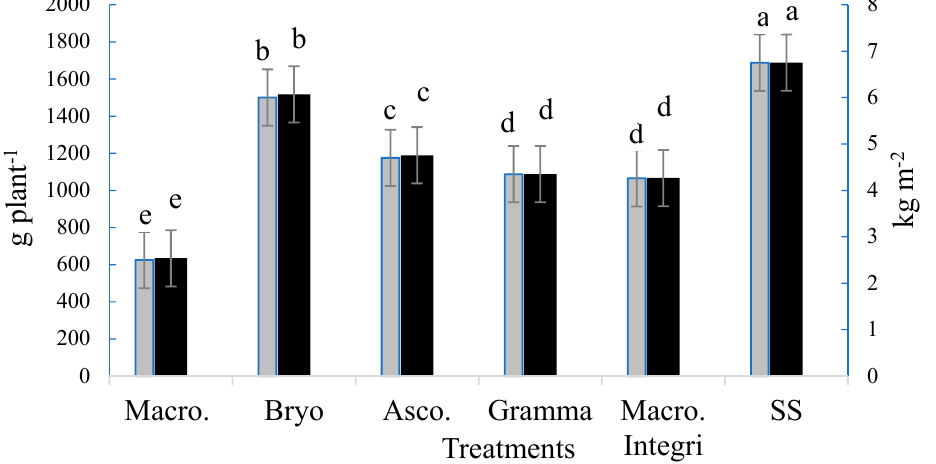
Figure 1. Effect of foliar application of seaweed extracts on the cucumber yield based on g plant − 1 (black bars) and kg m − 2 (grey bars) established in shade mesh. Means followed by the same letter are not significantly different between treatments (Tukey; p ≤ 0.05). Macro. = Macrocystis pyrifera , Bryo = Bryothamnion triquetrum , Asco. = Ascophyllum nodosum , Gramma = Grammatophora spp., Macro. integri = Macrocystis integrifolia , SS = Steiner solution.